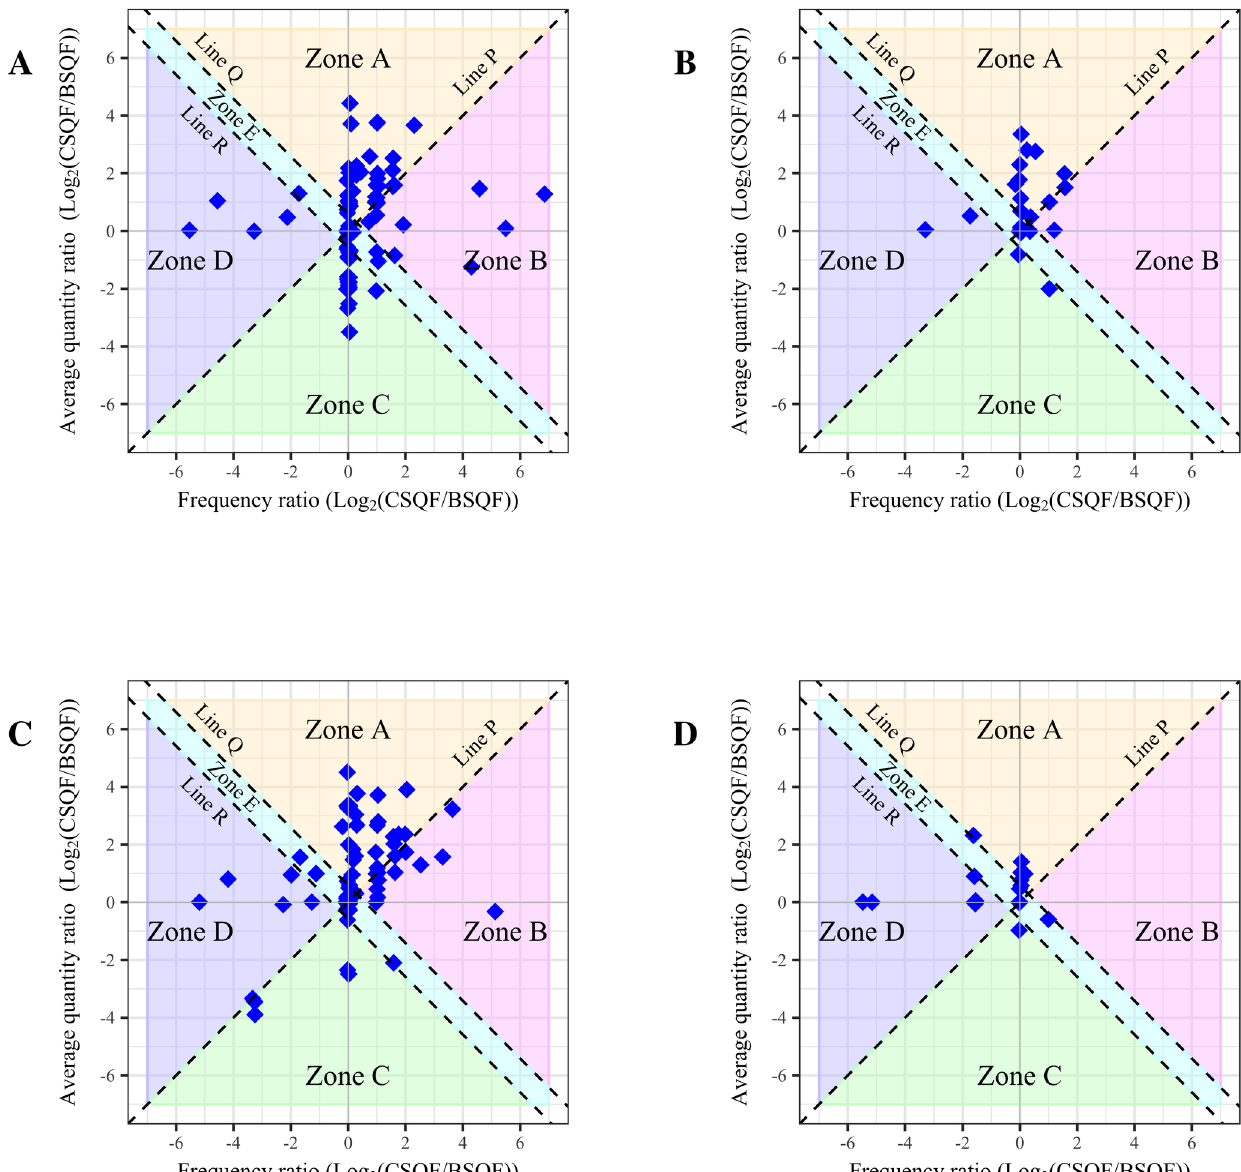
Fig 2. Jitter plots of drinking frequency ratio and average quantity ratio for beer (2A), white spirits (2B), whisky (2C), and other beverages (2D) Zone A represents CSQF over-report by average quantity, Zone B represents CSQF over-report by frequency, Zone C represents BSQF over-report by average quantity, Zone D represents BSQF over-report by frequency, and Zone E represents equivalence; Line P represents the equality of effect line, Line Q represents CSQF over-report of 1.5 times, and Line R represents BSQF over-report of 1.5